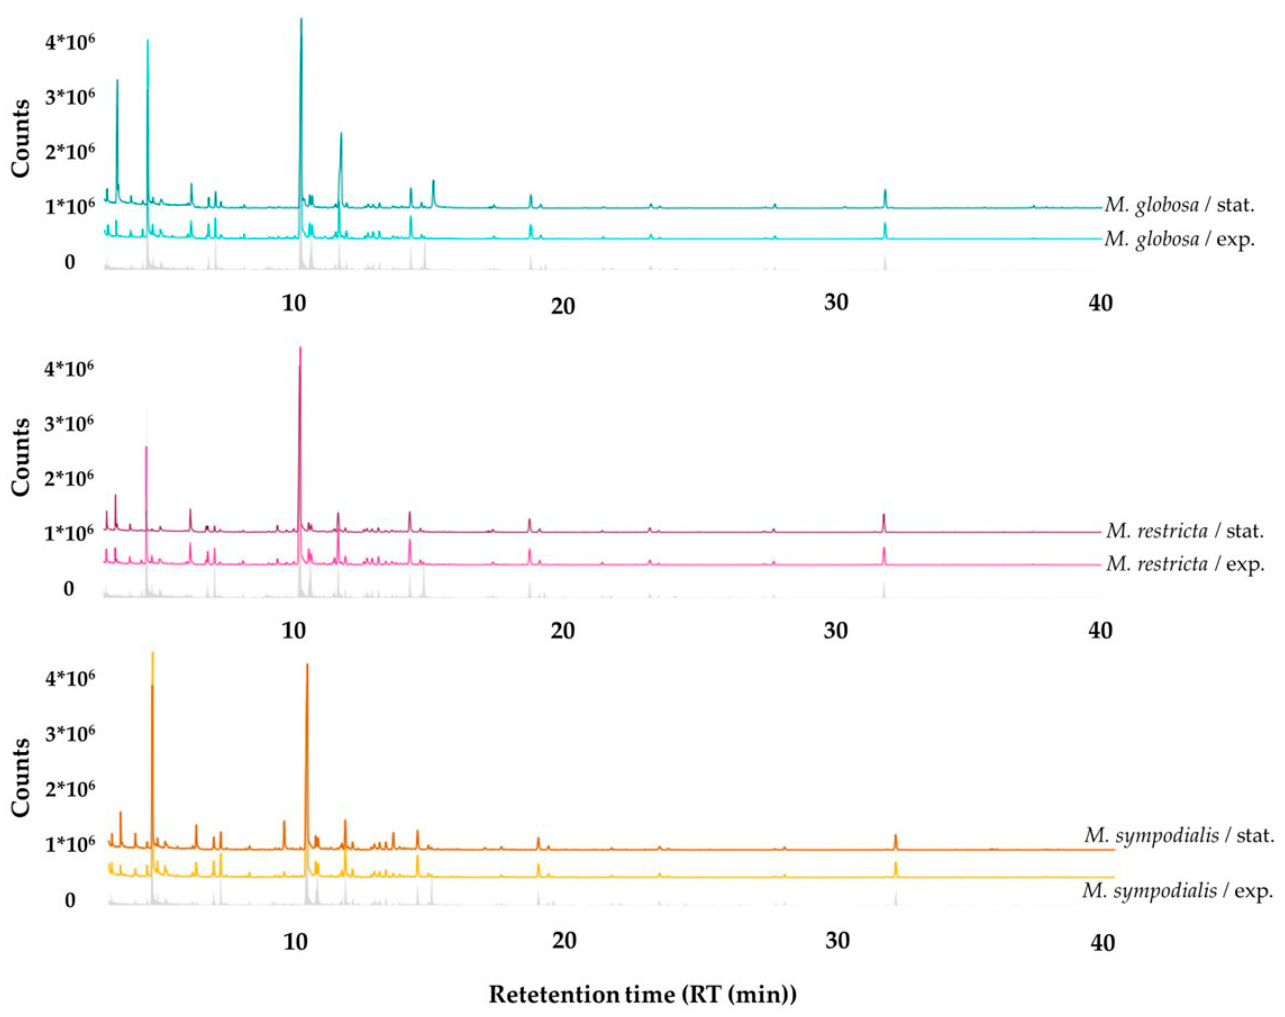
Figure 3. Gas chromatographic profiles of volatile organic compounds (VOCs) detected in the headspace of Malassezia spp. in the exponential and stationary growth phases. The gray line corresponds to the volatile profile of the control, which is mDixon media without yeasts.